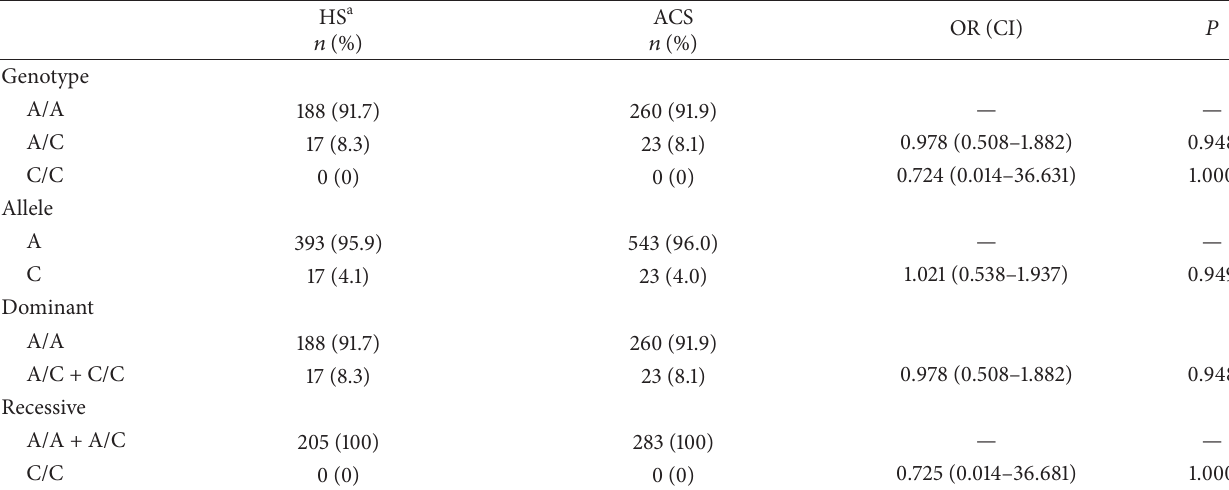
Table 2: Allele and genotype distribution of rs5361 (561A > C) E-selectin polymorphism by